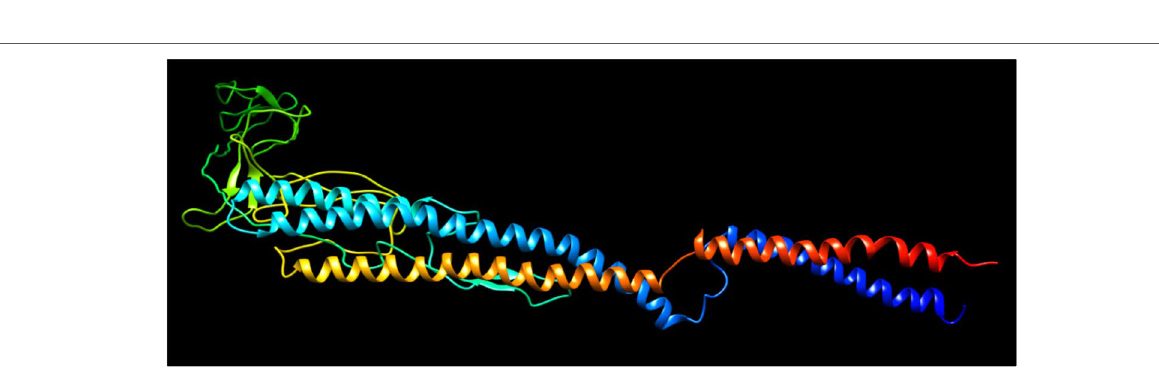
Fig. 3 The I‑Tasser server anticipated the vaccine construct’s tertiary